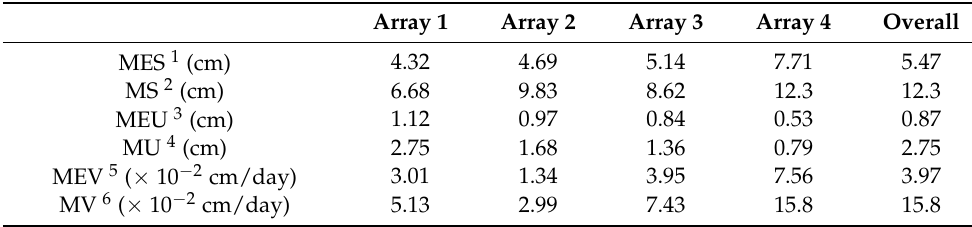
Table 3. Amount and velocity of subsidence and uplift.